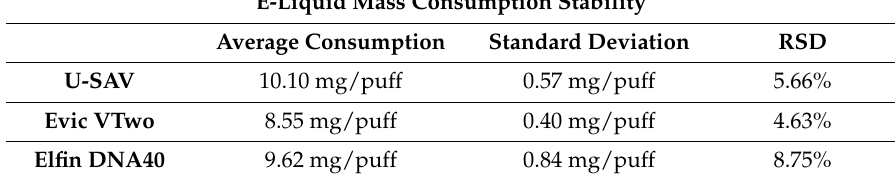
Table 4. Mass variation of liquid A from 36 measurements (6 per U-SAV line) comparing energy delivery from U-SAV with two commercial electronic cigarette (EC) battery